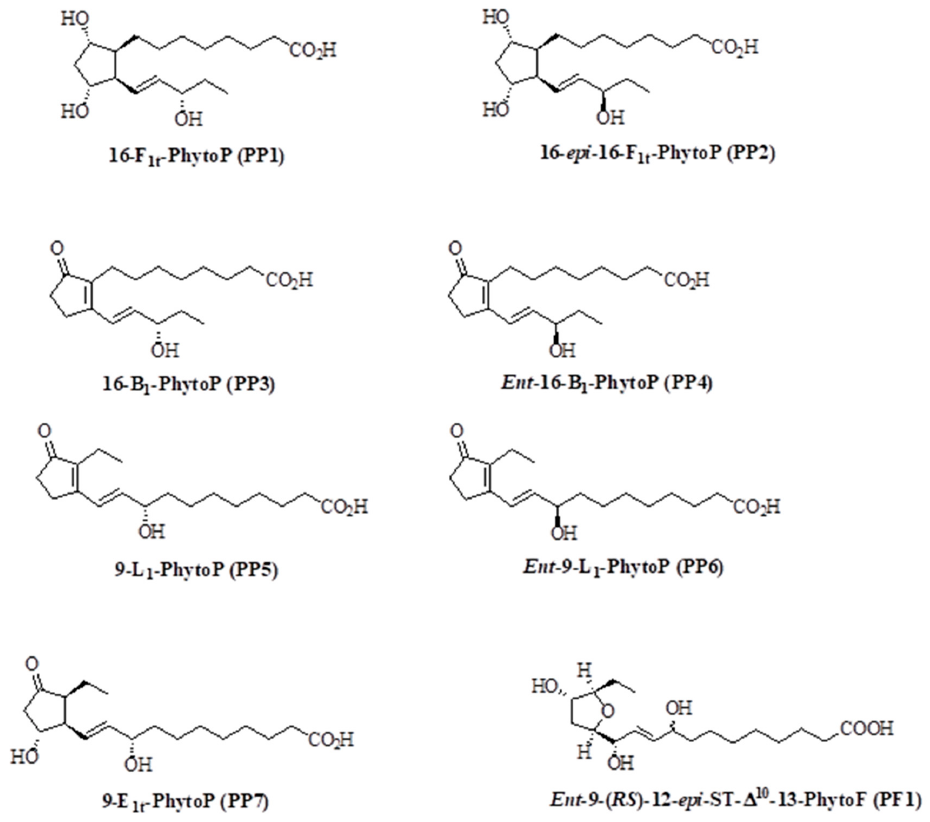
Figure 1. Structure of the phytoprostanes used in this study.